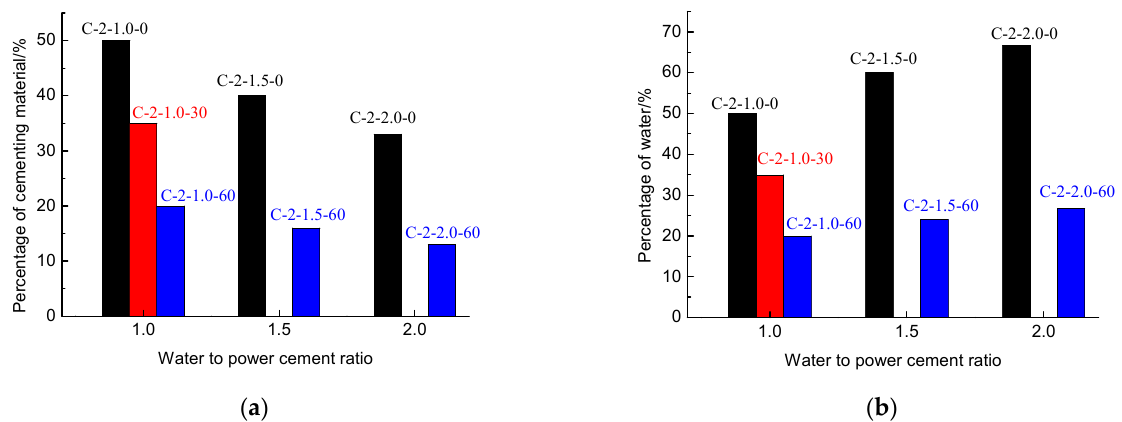
Figure 12. Material consumption of CSBM specimens: ( a ) the mixing amounts of cementing material with varying ratios of water to powder cement (1.0, 1.5, and 2.0); ( b ) the mixing amounts of water with varying ratios of water to powder cement (1.0, 1.5, and 2.0).